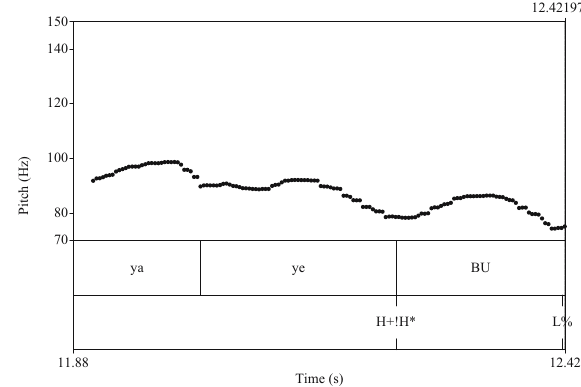
Figure 5: Dissatisfaction shown through